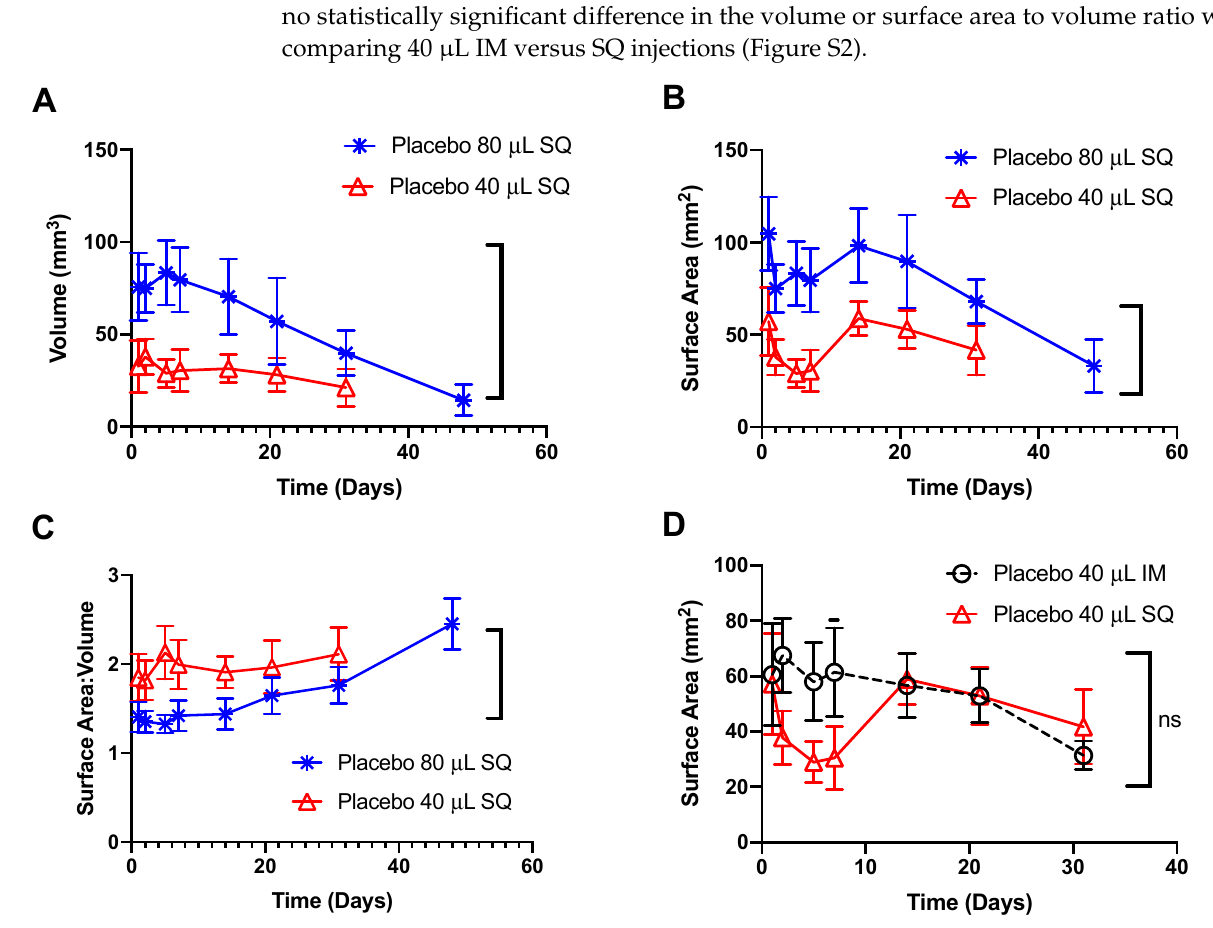
Figure 4. Volume and surface area of 80 µ L ( n = 8 mice/group; 1 ISFI/mouse) and 40 µ L ( n = 5 mice/group; 2 ISFIs/mouse) placebo ISFIs (1:2 w / w PLGA/NMP) injected into female NSG mice: ( A ) Volume of 80 and 40 µ L SQ placebo ISFIs over 45 days ( p = 0.0043), calculated by segmenting the ISFI boundary from multiple slices across 3 dimensions and interpolating the segmented volume. ( B ) Surface area of 80 and 40 µ L SQ placebo ISFIs over 45 days ( p = 0.0027), calculated by segmenting the ISFI boundary from multiple slices across 3 dimensions and interpolating the segmented surface area. ( C ) Surface area to volume ratio of 80 and 40 µ L SQ placebo ISFIs over 45 days ( p = 0.0281). ( D ) Surface area of SQ and IM 40 µ L placebo ISFIs over 30 days (n.s.; day 7 individual p < 0.001). All statistics were unpaired t-tests.